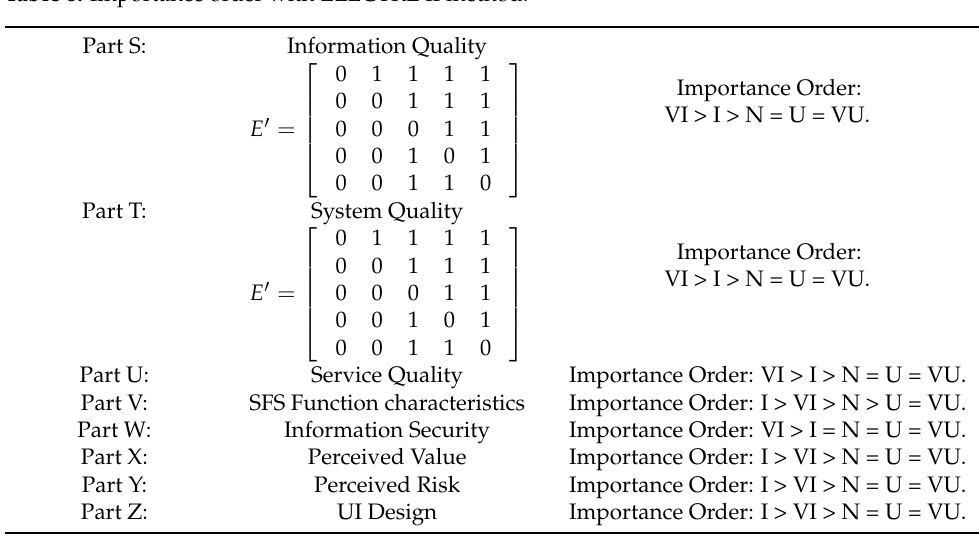
Table 8. Importance order with ELECTRE II method.